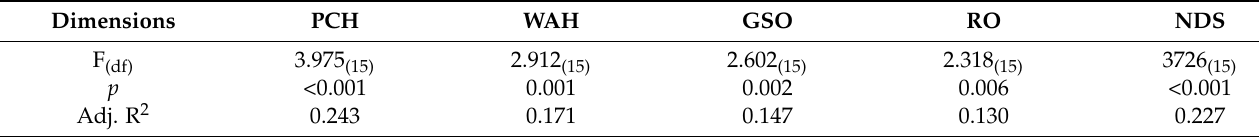
Table 3. Results of Multiple Regression Analysis by Dimension of